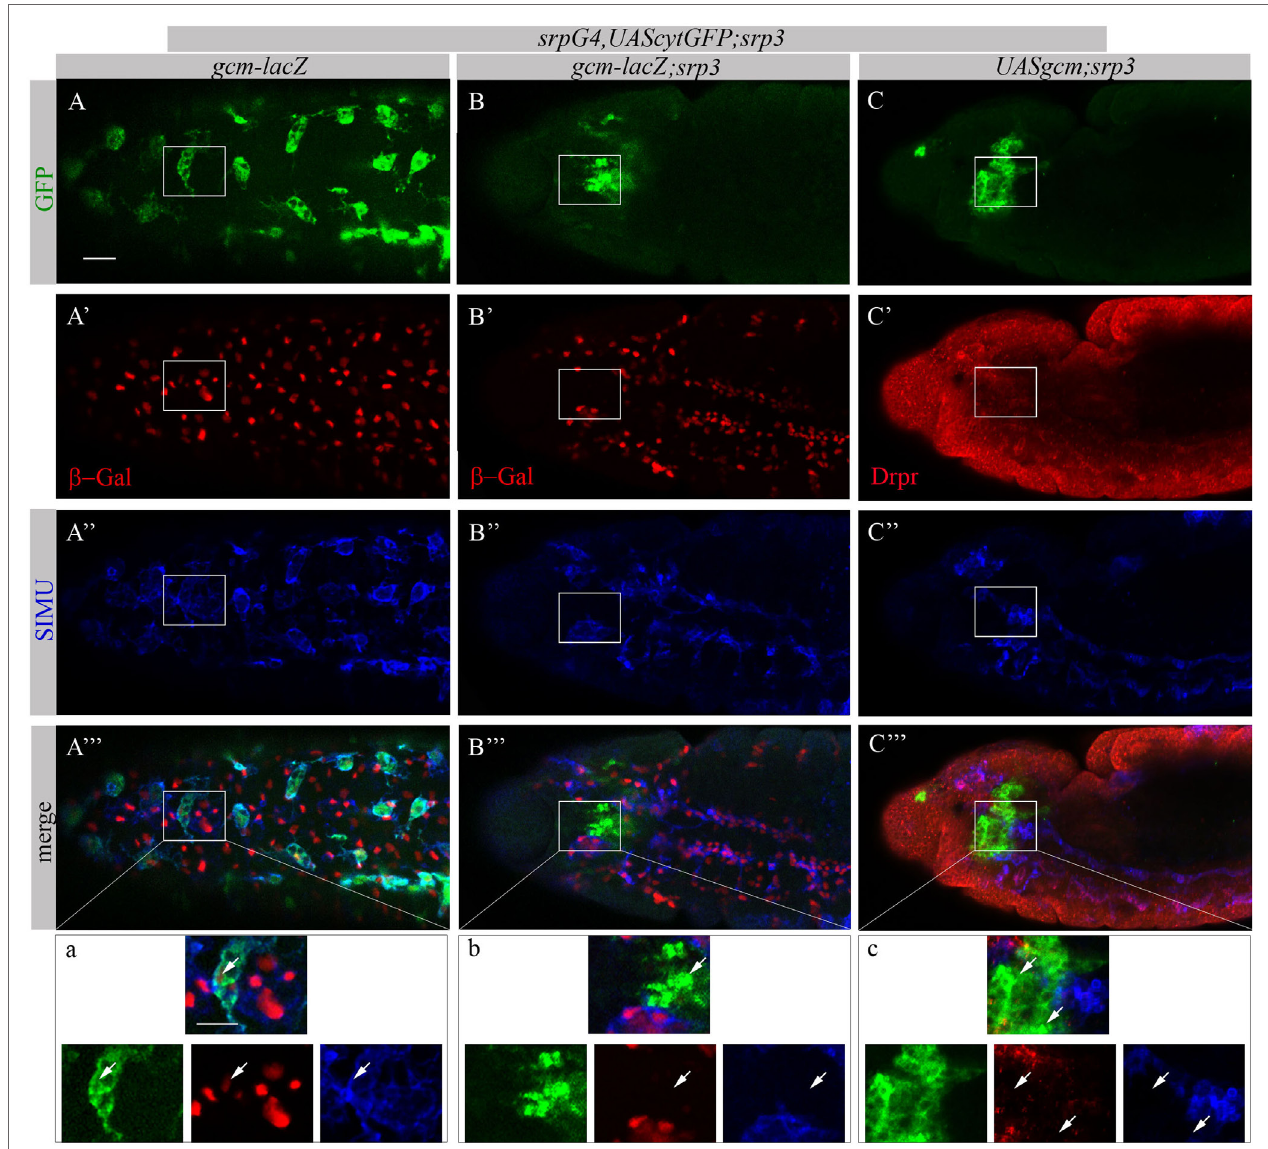
FigUre 9 | GCM is not sufficient to drive SIMU and Drpr expression in embryonic macrophages. (a–c) Projections from confocal stacks of the stage 16 embryos, (a–a) ventral view and (B–c) lateral view. Macrophages are labeled with srpGal4,UAScytGFP [green, (a,a’’’,a,B,B’’’,b,c,c’’’,c) ] and SIMU protein with anti-SIMU [blue, (a’’,a’’’,a,B’’,B’’’,b,c’’,c’’’,c) ]. (a–b) gcm-lacZ reporter in red and (c–c) Drpr with anti-Drpr in red. (a–a) Control srpGal4,UAScytGFP embryo. β -Gal and SIMU are expressed in GFP-positive macrophages (arrows). (B–b) srp 3 mutant embryo. No β -Gal and SIMU are detected in GFP-positive cells (arrows). (c–c) srp 3 mutant carrying GCM (srpGal4::UASgcm) in macrophages. No SIMU and Drpr are detected in GFP-positive cells (arrows). Bar, 20